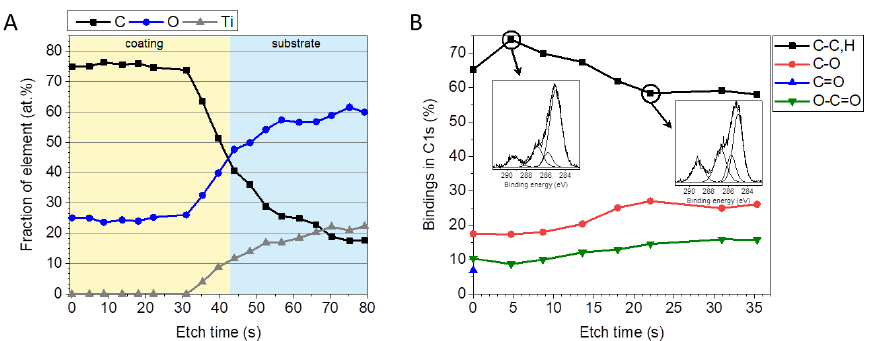
Figure 9. XPS depth profile from the Ar cluster-etched (10 keV Ar 1000 + ) HEMA-based polymer film, showing C 1s, O 1s and Ti 2p signals, depending on the etch time ( A ) and functional group distribution determined from the corresponding high-resolution C 1s spectra ( B ).